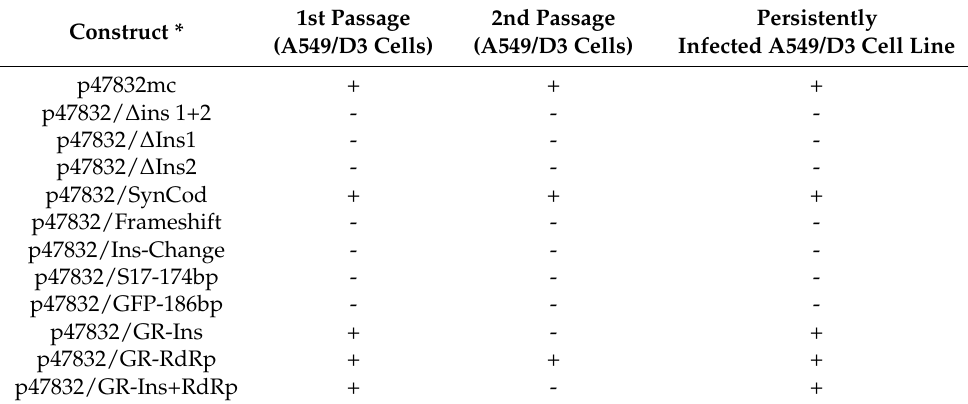
Table 1. Summary of the generation of HEV 47832c mutants based on the capsid protein detection by immunofluorescence analysis of cells. (+) positive, (-)